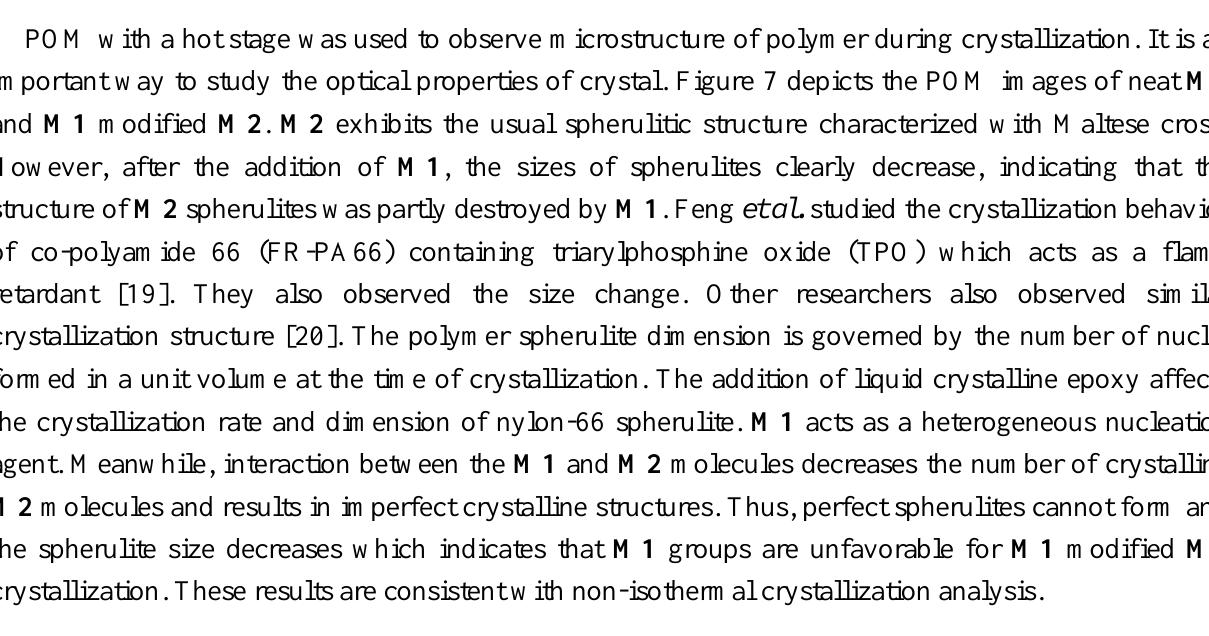
Figure 7. Polarized optical microscopy (POM) images of nylon 66 ( a ) and LCE-nylon 66 ( b ) after holding at 268 °C for 40 min then slowed cooled